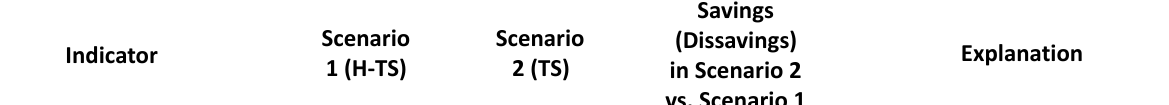
Table 6. Quantitative assessment of selected indicators for the dispersed and compact development scenarios in the Leipzig-Halle Region. Dissavings are shown in parentheses with a negative sign. By slow modes of transportation, we refer to walking and cycling. (Cont.)